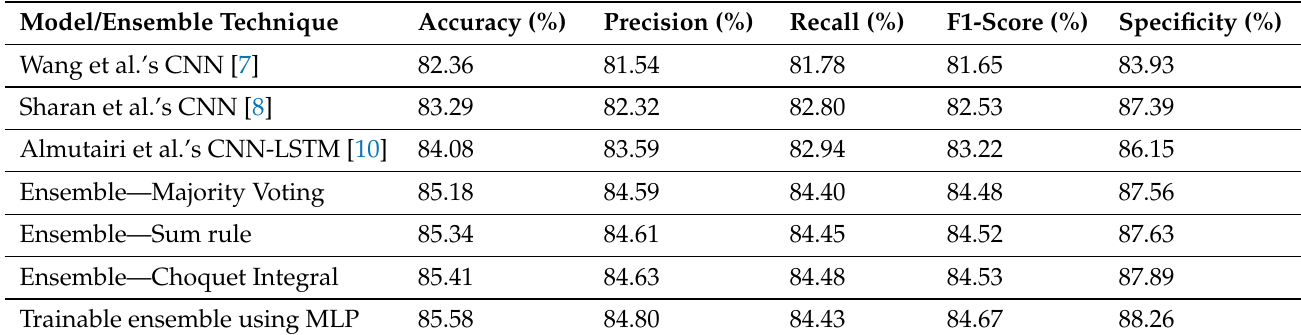
Table 1. Classification performances obtained by all the base models and their ensembles.